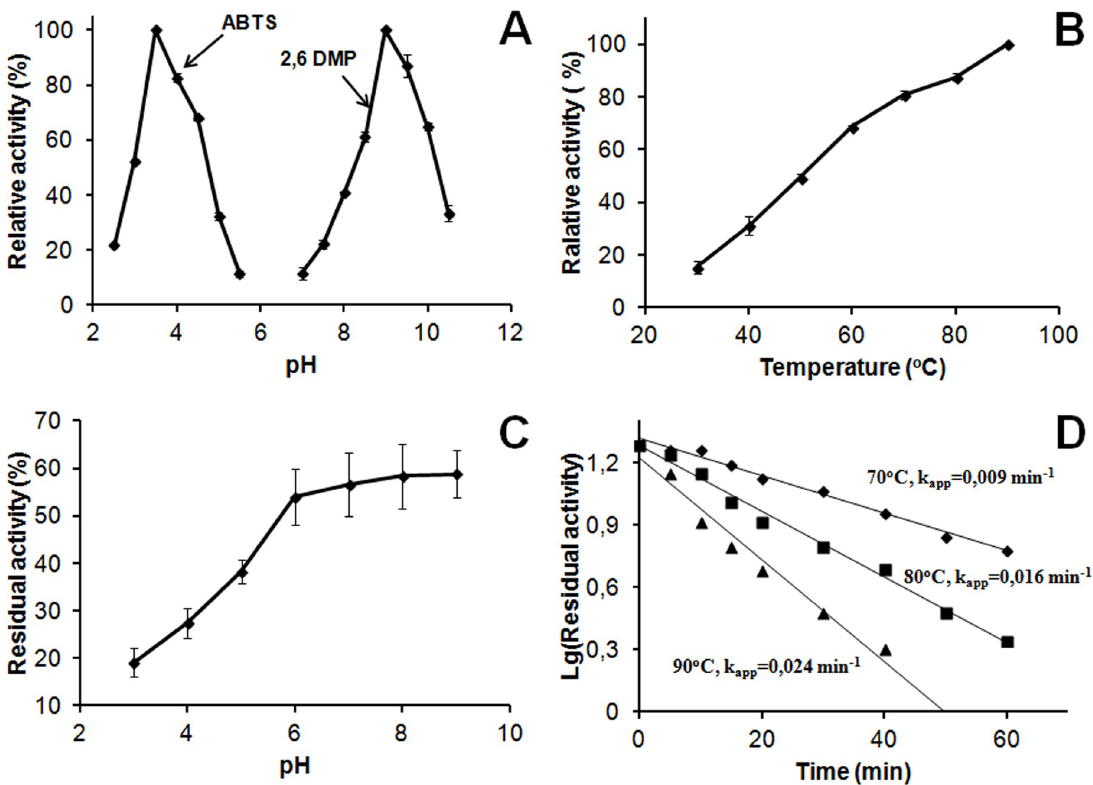
Fig 2. Properties of SpSL. (A) pH optimum of the enzyme with ABTS and 2,6-dimethoxyphenol;(B) effect of temperature on SpSL activity; (C) pH stability; (D) thermal stability at 70, 80 and 90˚C.